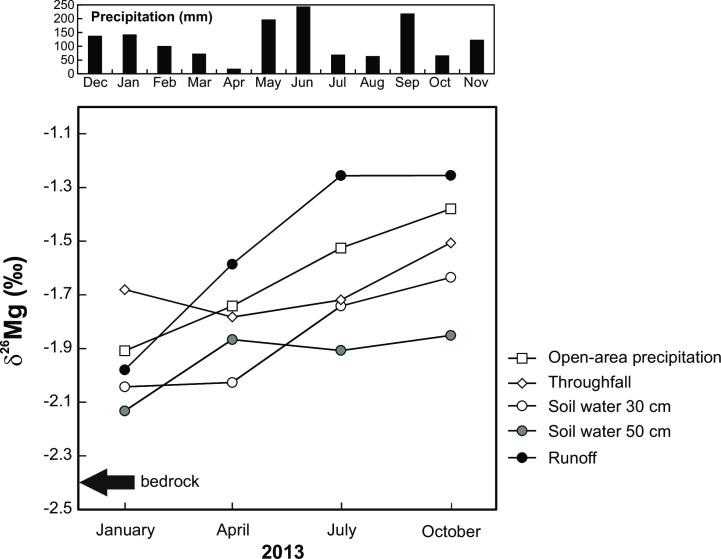
Temporal trend in δ26Mg values of individual types of water samples at UDL.Magnesium concentrations in runoff roughly correspond to those of soil water; Mg in soil water is more concentrated than Mg in rainfall due to evapotranspiration, biological cycling, and water-rock interaction (Table 1).